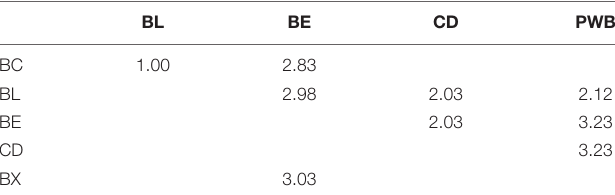
TABLE 4 | Multi-collinearity